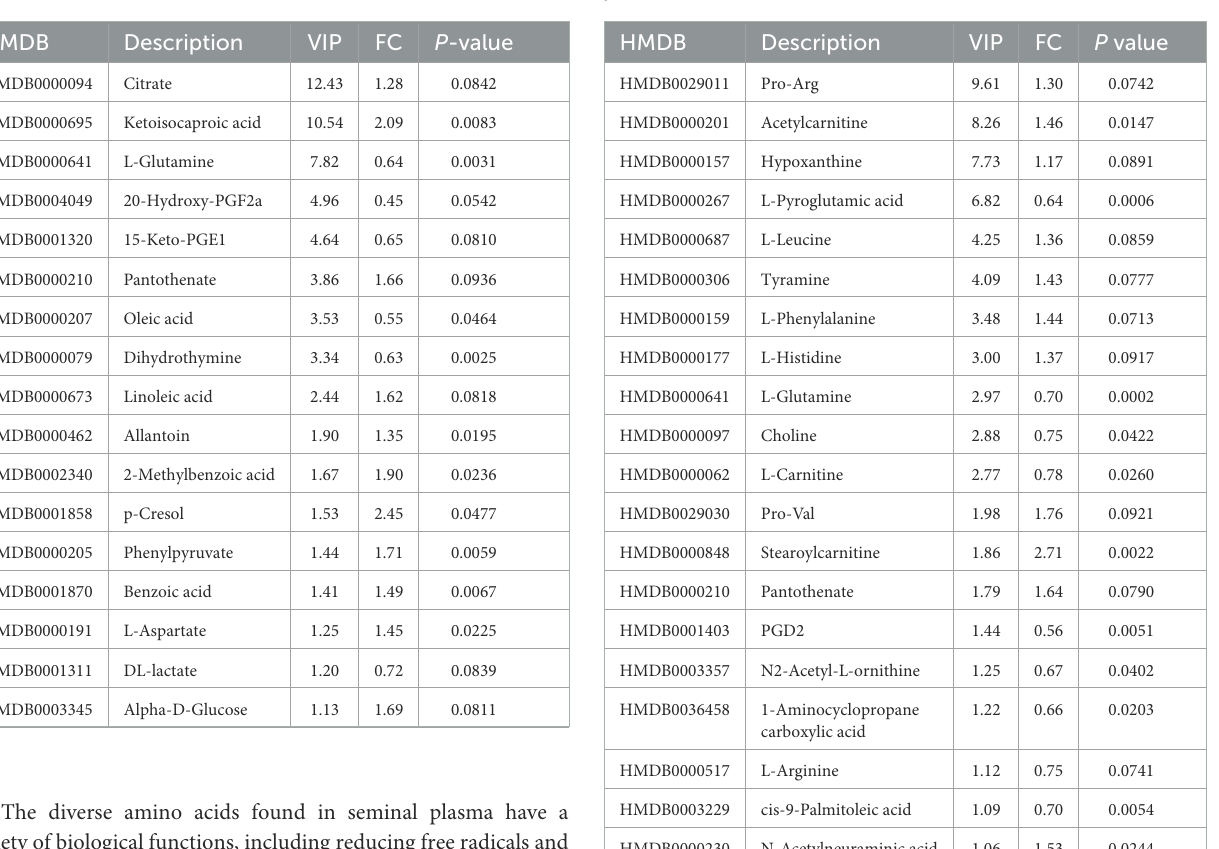
TABLE 2 Differential metabolites between the LF and HF groups in the negative ion mode.